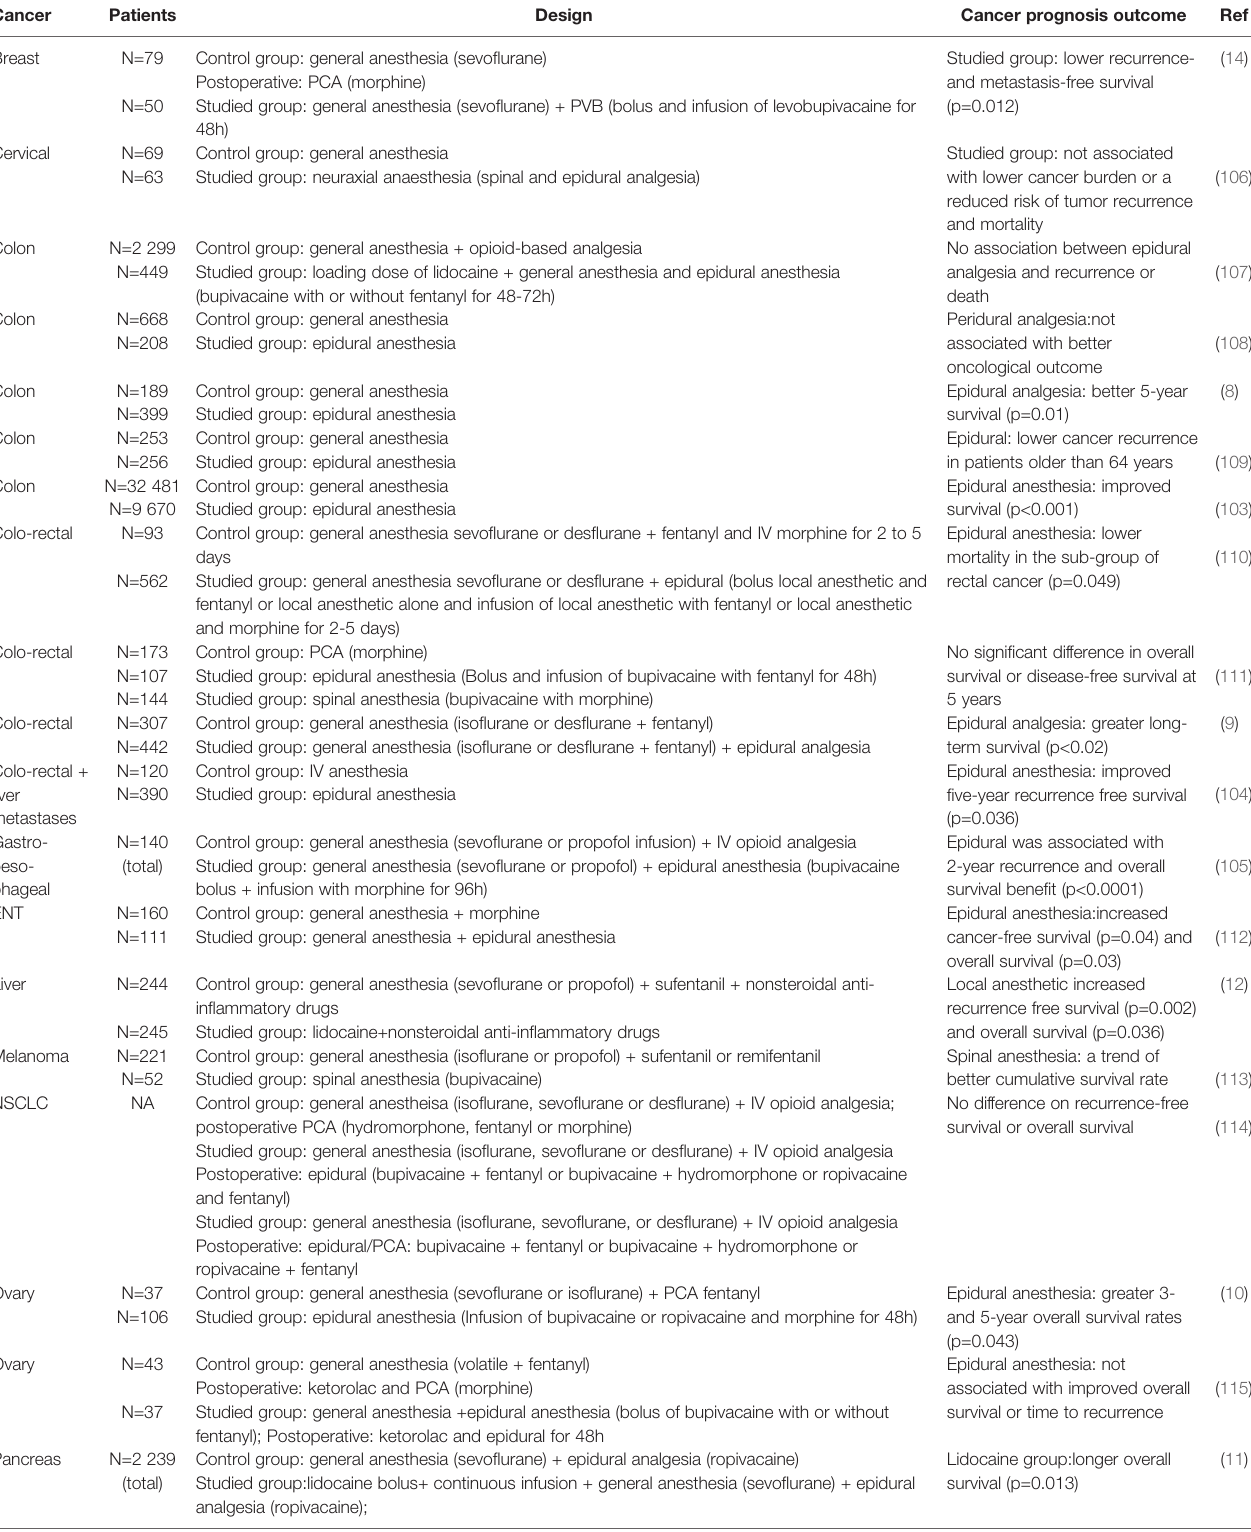
TABLE 2 | Retrospective studies assessing local anesthetics impact on cancer prognosis. Cancer